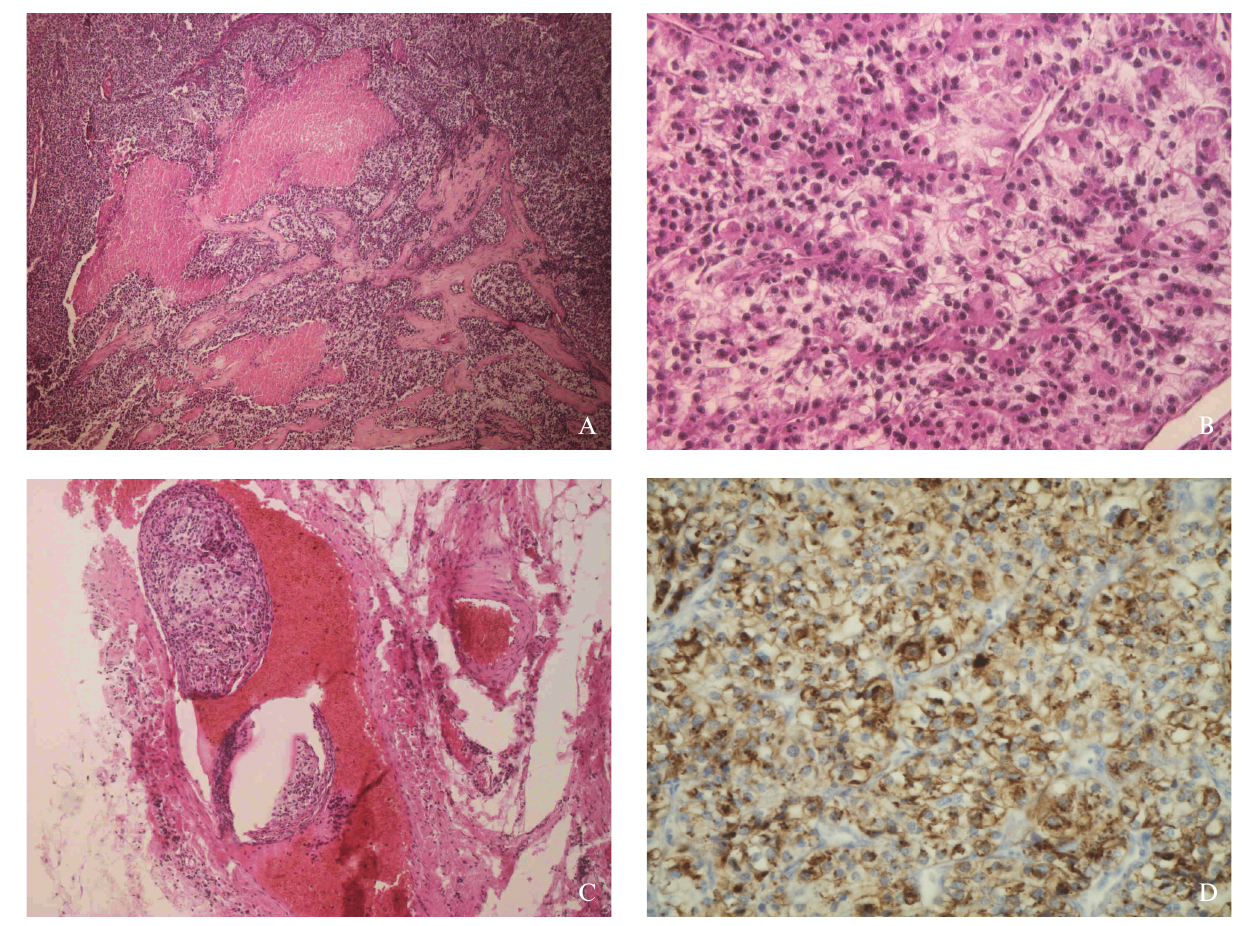
Fig. 1. Histology of parathyroid carcinoma. (A) On histological examination of the primary tumor solid carcinoma with areas of necrosis and fibrous septa was evident (hematoxylin-eosin staining, original magnification 40x. (B) Part of the tumor section with trabecular and rosette-forming cells with clear or eosinophil cytoplasm and low mitotic activity (hematoxylin-eosin staining, original magnification 200x). (C) Angioinvasion of the tumor (hematoxylin-eosin staining, original magnification 100x). (D)